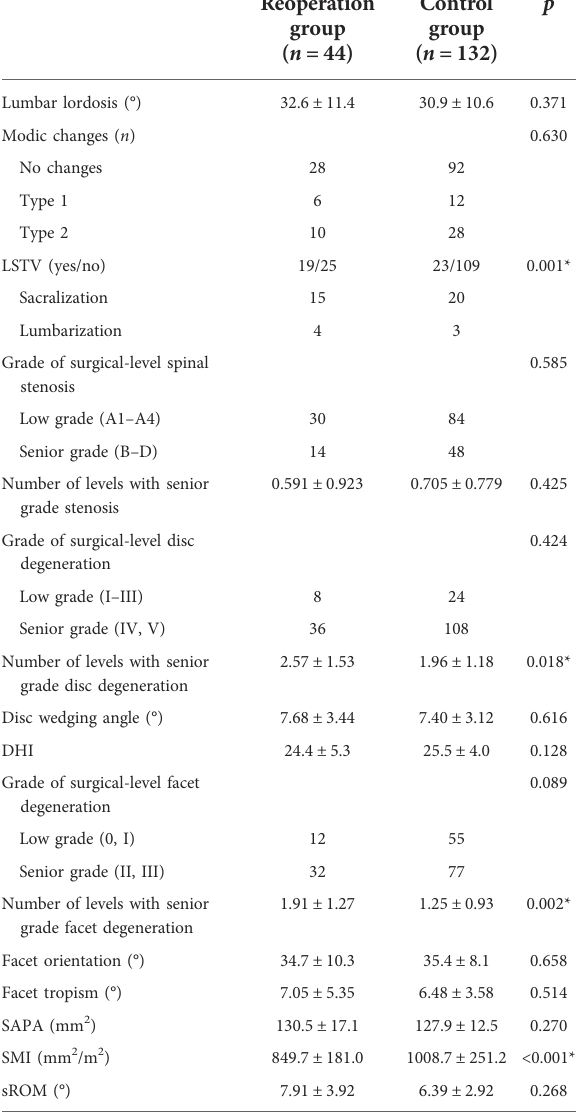
TABLE 4 Multivariate regression model of the predictors for reoperation following percutaneous transforaminal endoscopic